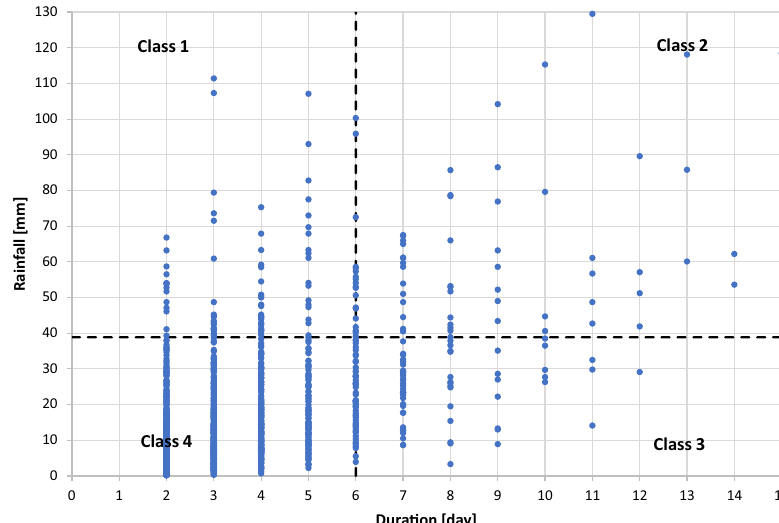
fig. 6. Distribution of precipitation sequence lengths and totals in the 1951–2020 period at the iMGW station in